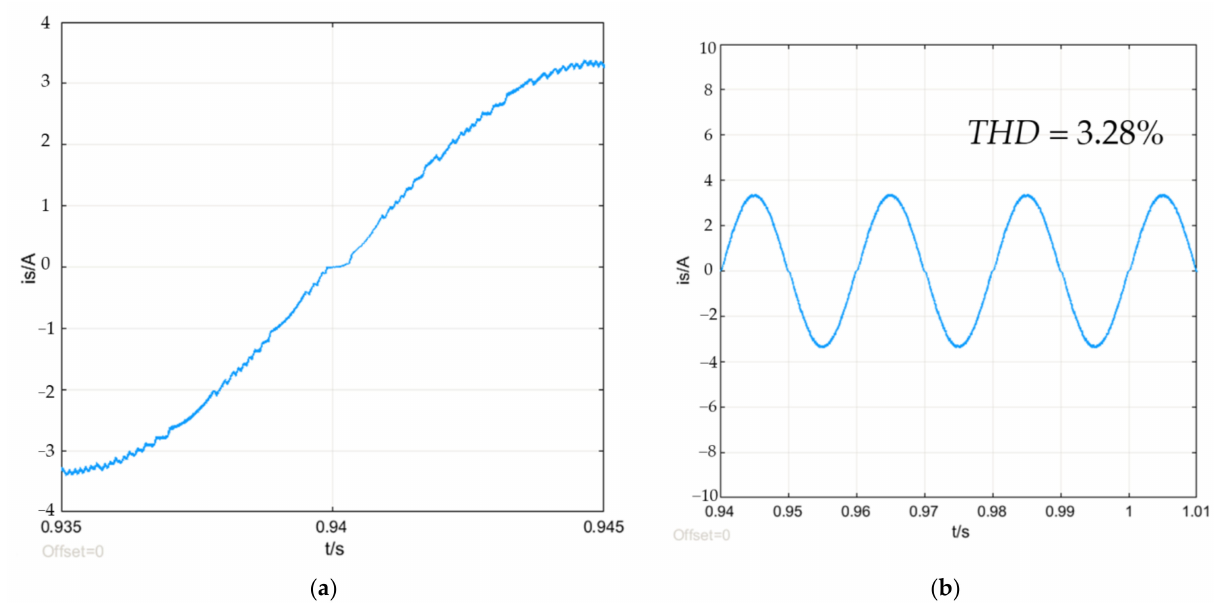
Figure 12. The simulated current waveform when the dead-time is 6us and there is no dead-time compensation. ( a ) The full cycle waveform of the current; ( b ) The waveform when the current crosses zero.